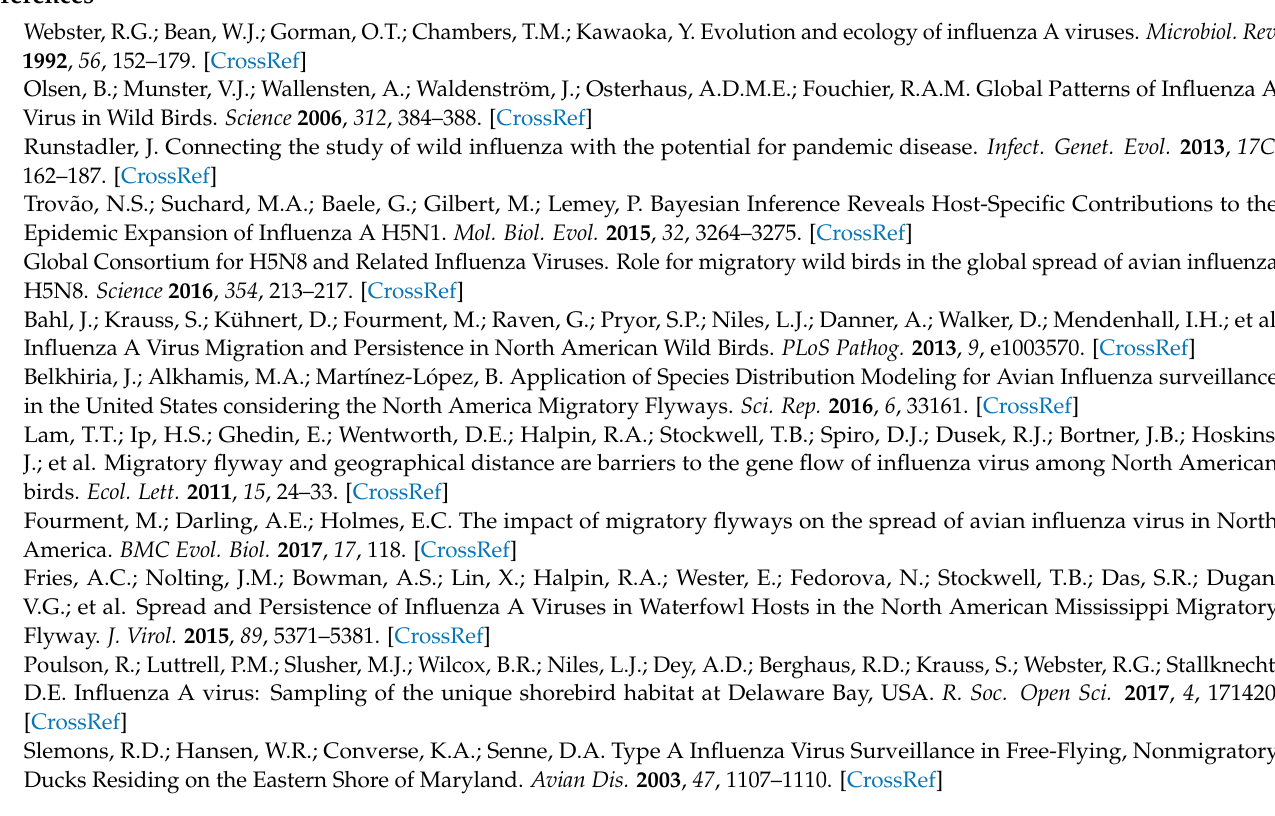
Table S6: Percentage of Markov jump counts for the trait regarding the number of introductions per